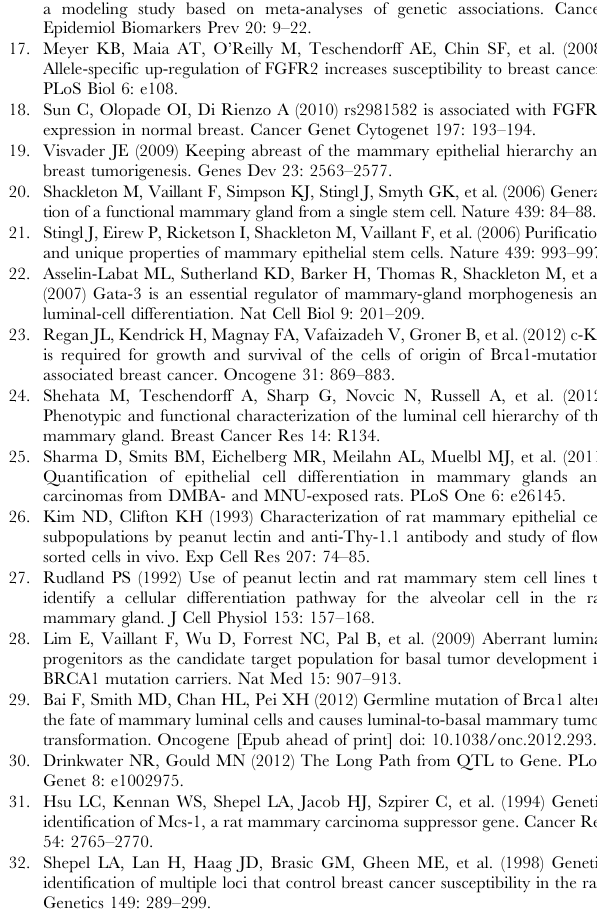
gUwm, g2Uwm, bUwm are microsatelite markers. rf are SNP markers, discovered by resequencing rat-fugu (rf) conserved elements in the Mcs1a locus; variants are listed in Table S3. Table S2 Positions are in basepairs on rat chromosome 2 (UCSC version 3.4/rn4). Table S3 Positions are in basepairs on rat chromosome 2 (UCSC version 3.4/rn4). For all variants, the WF allele matches the genome sequence (from the Brown Norway inbred rat strain). All variants have been submitted to dbSNP (accession number pending). Table S4 Listed are 1,531 genes with a unadjusted P-value of , 0.05, sorted by P-value starting with the 412 genes with 1-1-1 mouse-rat-human orthologs. LogFC = log of the Fold Change between the WT and MD samples. The WT.1-4 and MD.1-4 columns contain the RSEM output .nu values. Table S5 The same groups and background list were run using 2 online GO enrichment tools, GOrilla and DAVID. The enriched terms printed in red reach best significance, as determined by an adjusted P-value , 0.05 (FDR adjust in GOrilla, Benjamini- Hochsberg adjust in DAVID).